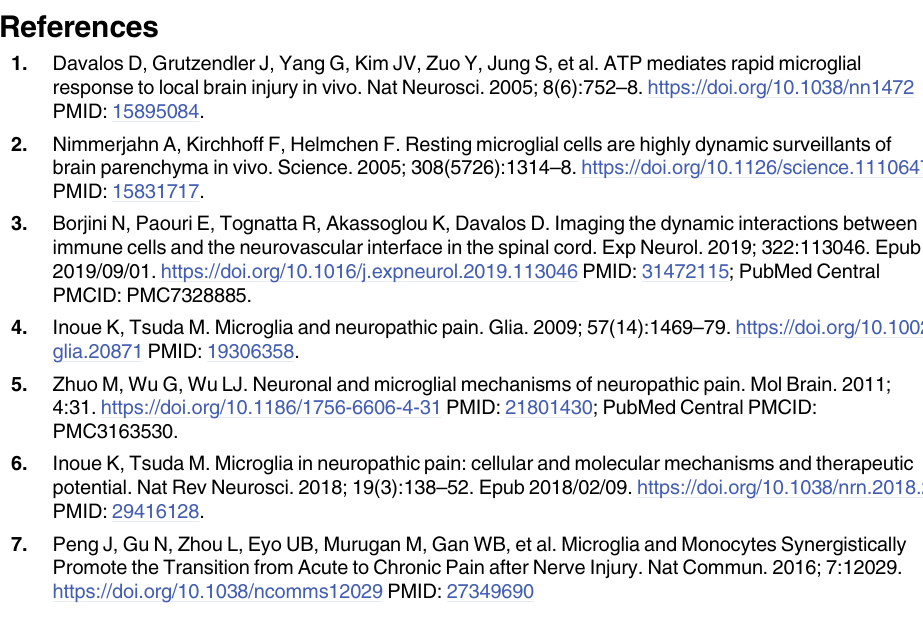
(green) in the spinal dorsal horn of ReaChR mice following i.t. injection of vehicle or IL-1ra (10 μ L, 50 ng/mL). PKC α expression was not detected in NeuN + cells receiving IL-1ra 3 days after light stimulation compared with vehicle group. Scale bar, 40 μ m. (B) Summarized data showing the co-localization of PKC α with NeuN + cells. Data are presented as mean ± SEM, n = 4 mice/group, ���� P < 0.0001, unpaired Student t test. For data plotted in graphs, see S1 Data. IL, interleukin; IL-1ra, IL-1 receptor antagonist; i.t., intrathecal; ReaChR, red-activated channelrhodopsin.